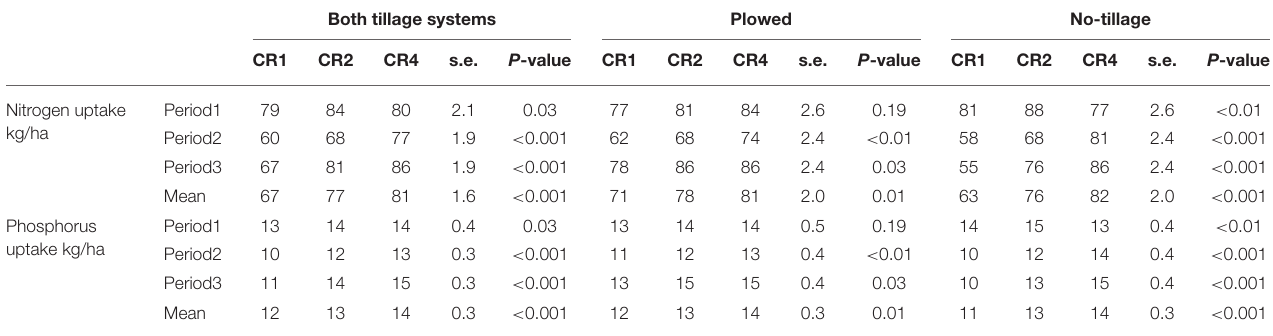
TABLE 4 | The average spring wheat nitrogen and phosphorus uptake in grain yield (kg/ha) in different tillage systems, time periods, and crop rotations. Both tillage systems